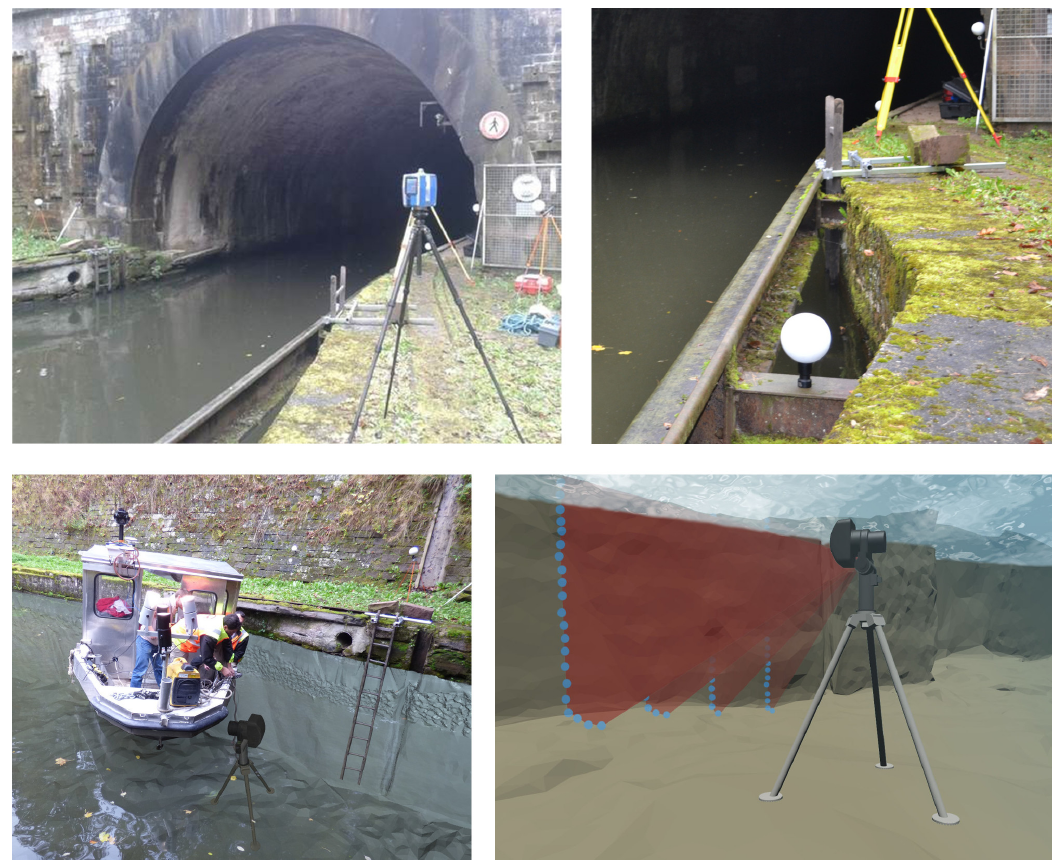
Figure 5. Data acquisitions in Niderviller’s tunnel: Photograph of the TLS device ( Top-left ); Zoom on a spherical targets and a ladder fixation on the dock side ( Top-right ); Schematic representation of MSS device positioning ( Bottom-left ) and Rotary scanning ( Bottom-right